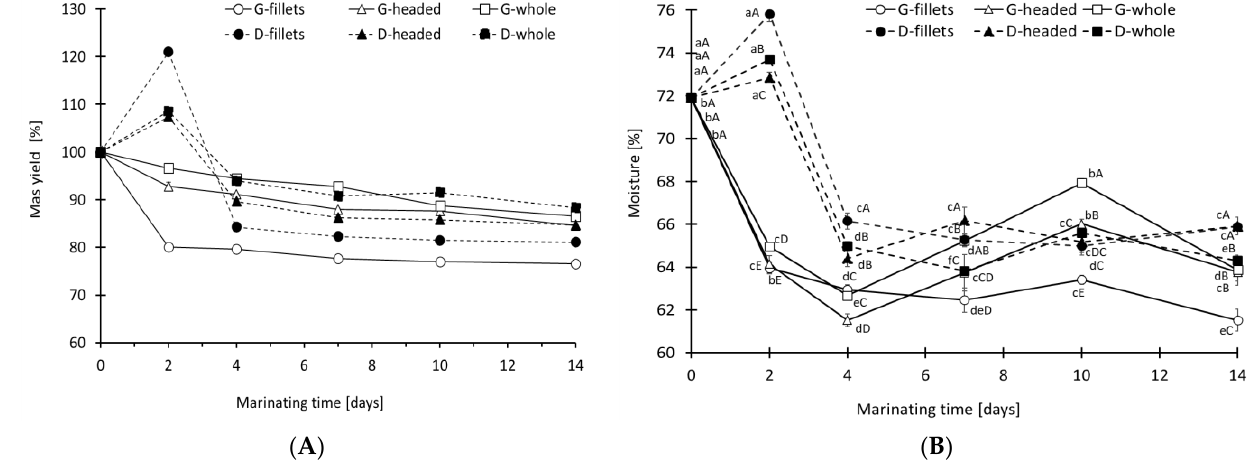
Figure 2. Effect of marinating method and degree of primary processing of Baltic herring (whole, headed, fillets) on ( A ) mass yield and ( B ) moisture during marinating. G- — German method, D- — Danish method. a,b,c Results marked with the same lower case letter do not statistically differ by the influence of marinating time; A,B,C Results marked with the same capital letter do not statistically differ by the influence of the marinating method.